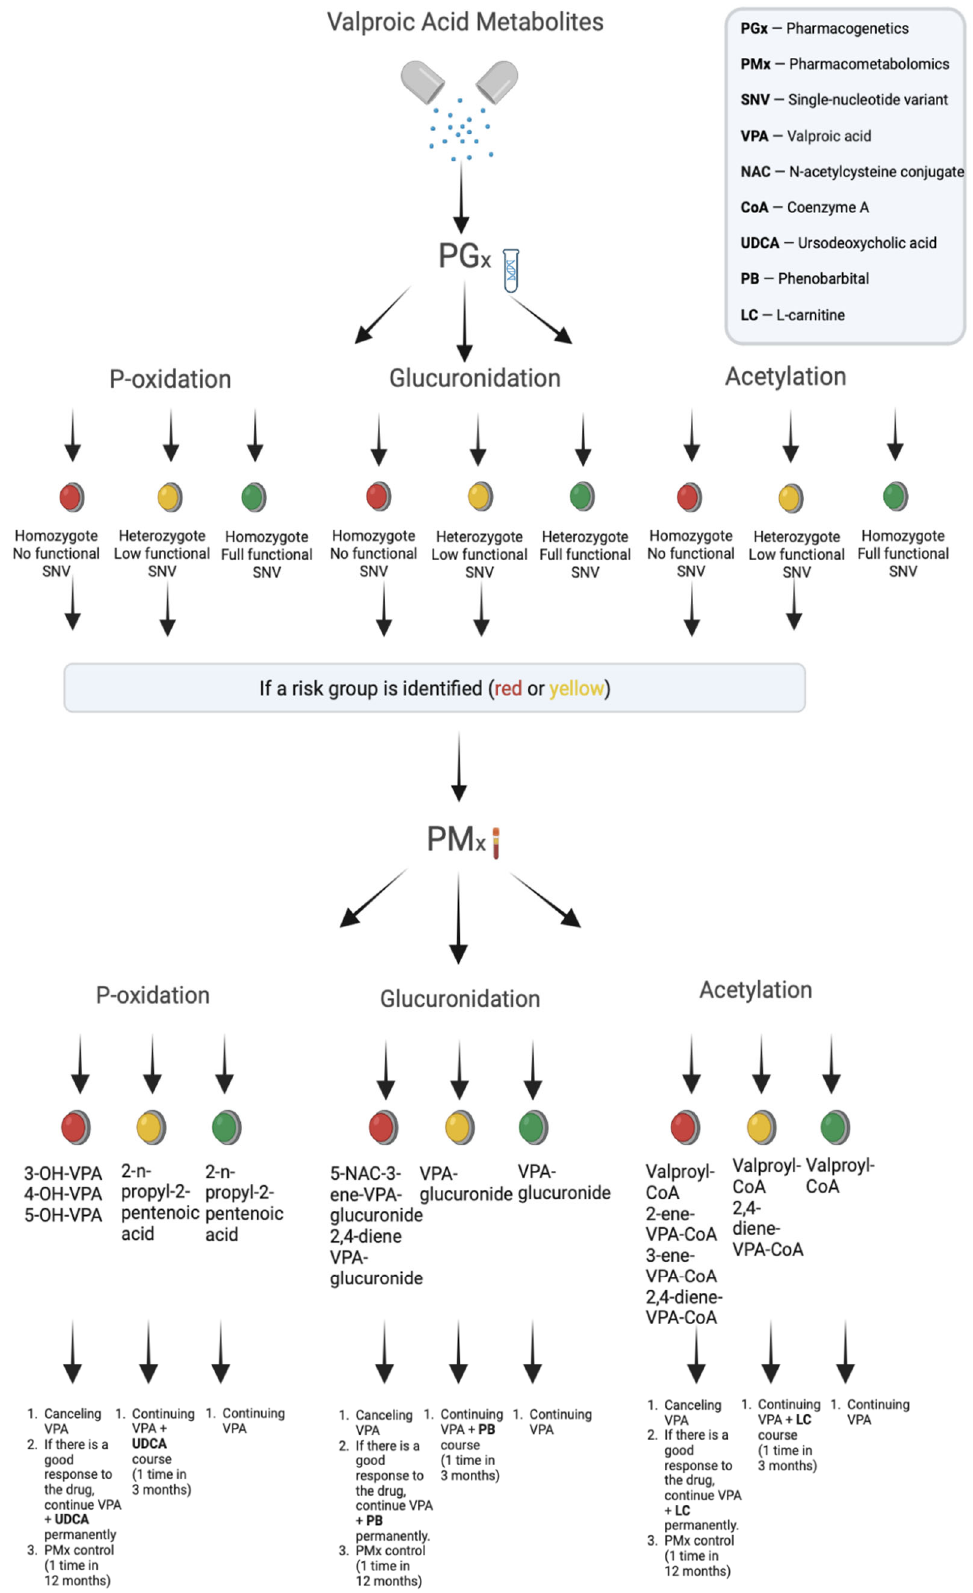
Figure 8. «The pharmacogenetics-informed pharmacometabolomics» approach to assessing the risk of development and correction of adverse drug reactions induced by valproic acid metabolites.